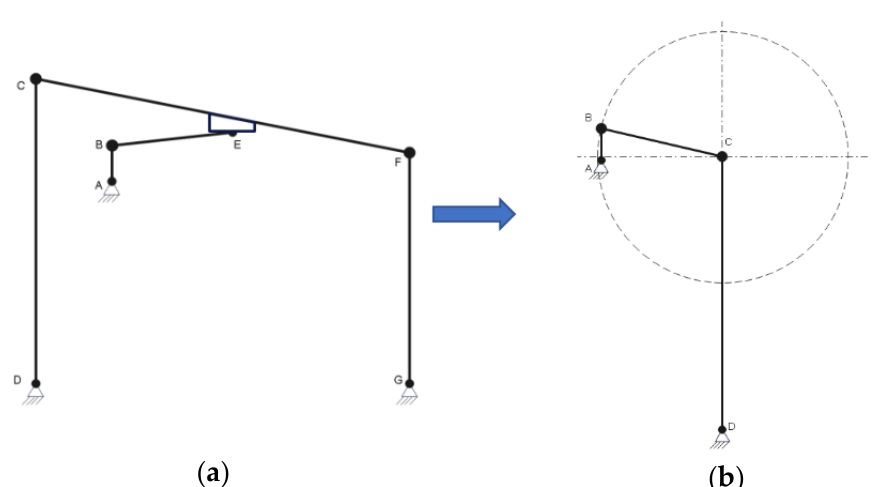
Figure 2. Model of the mechanism under study: ( a ) scheme for the drive system; ( b ) simplified model.